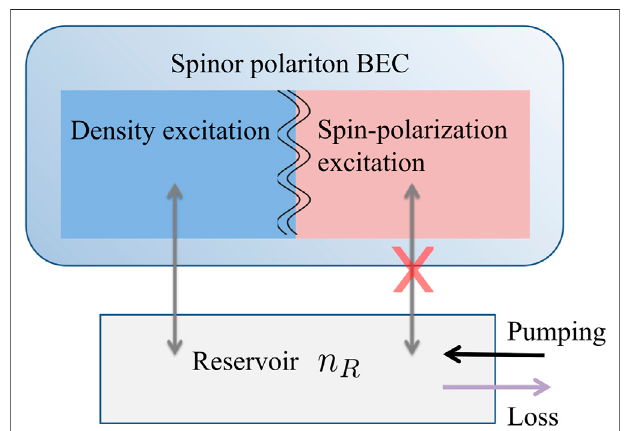
FIGURE 1 | Schematics of DMS formation in an open-dissipative polariton BEC under incoherent pumping, which is coupled to a reservoir via its density n R . On top of the steady state, there exist density (blue patch) and spin-polarization (red patch) excitation channels, which are usually coupled. However, once the pump balances the loss, the two channel, i.e., density excitation and spin-polarization excitation decouples (white curve). In such, the spin-polarization excitation is immune of the reservoir and a non-decaying DMS in spin-density excitation channel can occur.